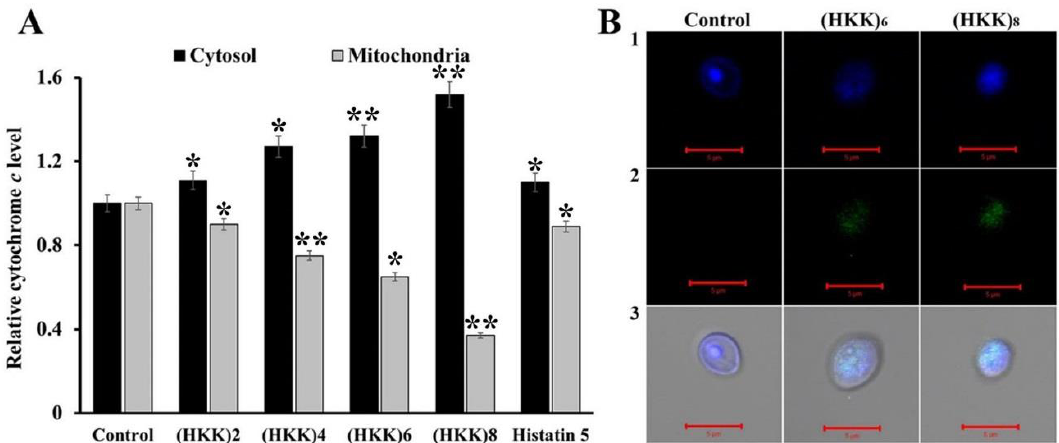
Figure 5. HKK peptide-induced apoptosis in C. albicans. ( A ) Release of cytochrome c from mitochondria to the cytosol in C. albicans was measured at 550 nm. Values represent the mean ± SD (* p < 0.05; ** p < 0.01), ( B ) CLSM images showing fungi treated with (HKK) 4 and (HKK) 8 and double stained with DAPI (1) and TUNEL (2). Merged images are shown in the lower panels (3).